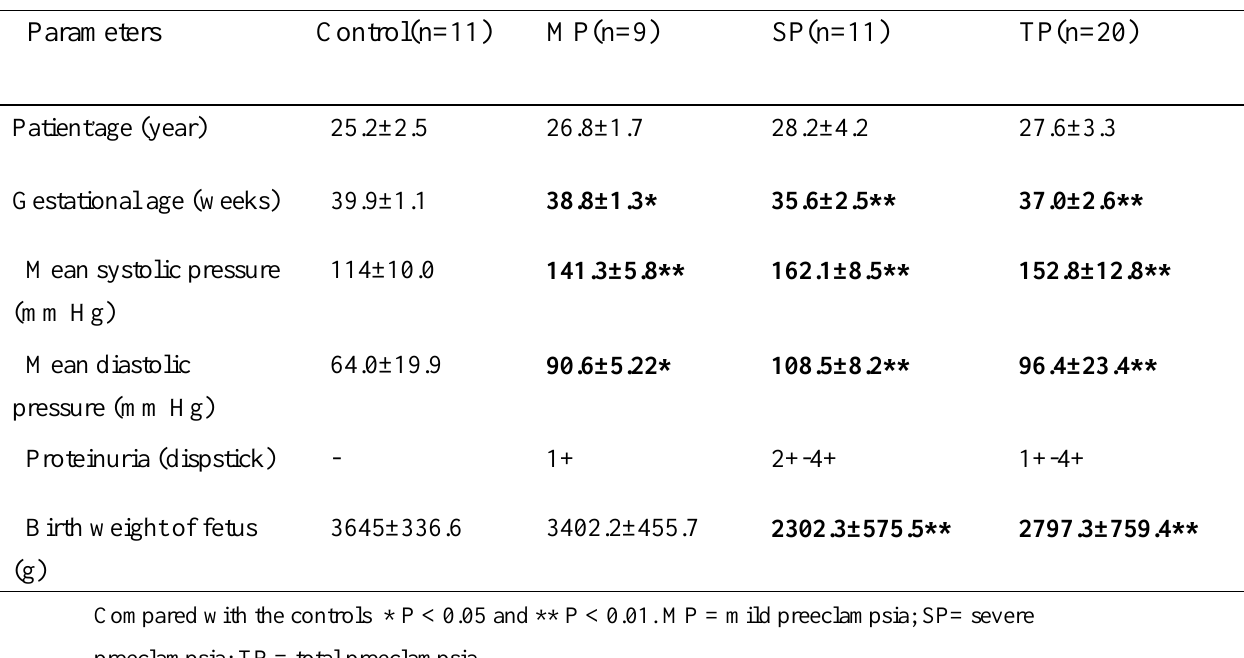
Table 1. Parameters from healthy pregnant women (control) group and three groups with